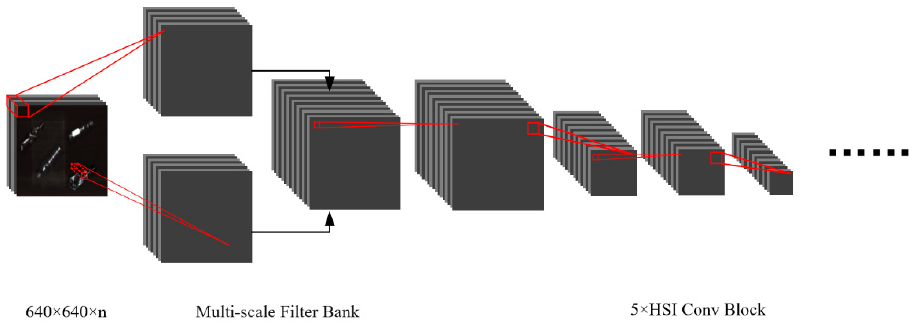
Figure 3. Network structure of HSI-CNN.